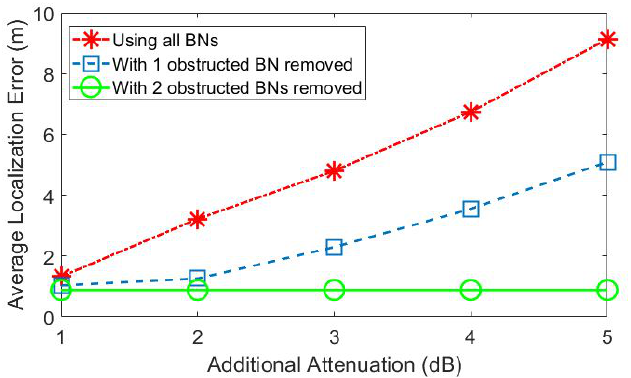
Figure 3. Effect of obstacles on sensor localization accuracy using the multilateration